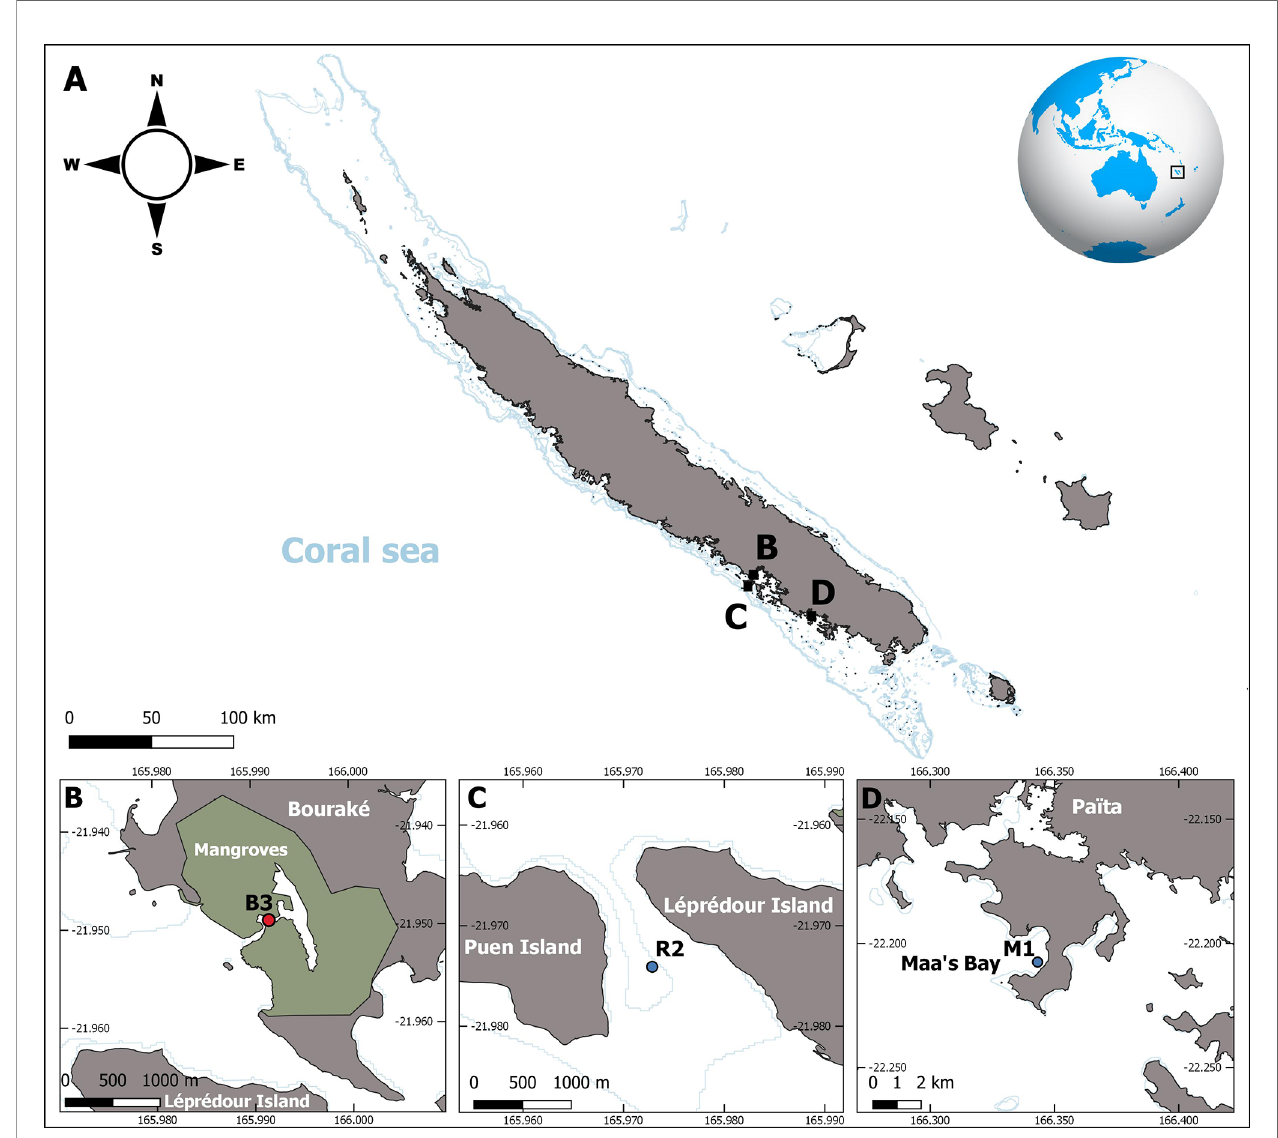
FIGURE 1 | Map showing the location of the study sites in New Caledonia (A) and the position of the stations where the 2-year experiment took place (B-D) . Station B3 was located in the semi-enclosed lagoon of Bourake ́ (B) , while two other stations were located either near Bourake ́ (St R2) (C) or in Maa ’ s Bay (St M1) (D)